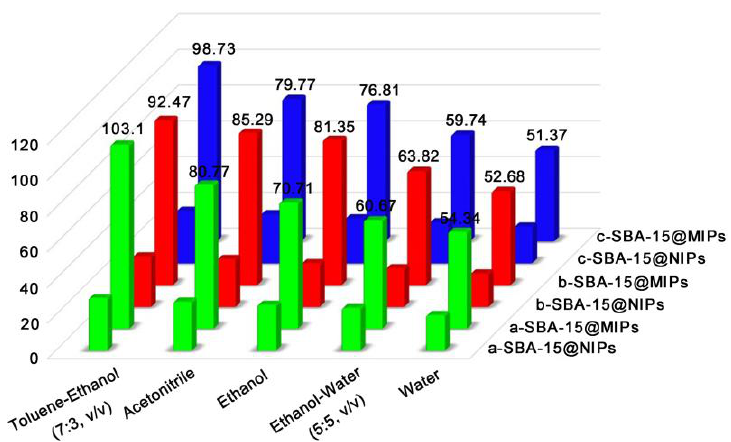
Figure 8. Recoveries of R 1 , Rg 1 , Rb 1 in the washing fractions of SBA-15@MT-MIPs and SBA-15@MT- NIPs with different washing solvents (a: R 1 , b: Rg 1 and c: Rb 1 ). NIPs with different washing solvents (a: R 1 , b: Rg 1 and c: Rb 1 ).